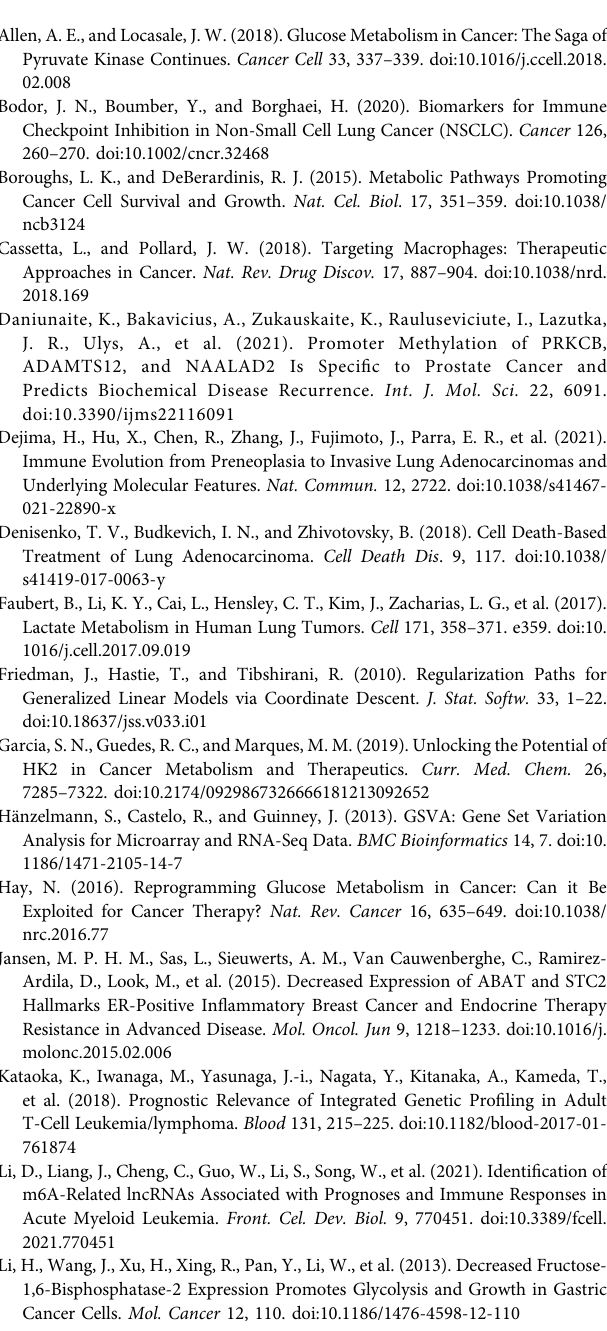
Supplementary Figure 5 | Correlation between the enrichment score of each pathway and the LUAD patients with tumor stage. Supplementary Figure 6 | Correlation between the enrichment score of each pathway and the risk score. Supplementary Figure 7 | Correlation between the expression of checkpoints and each gene of the